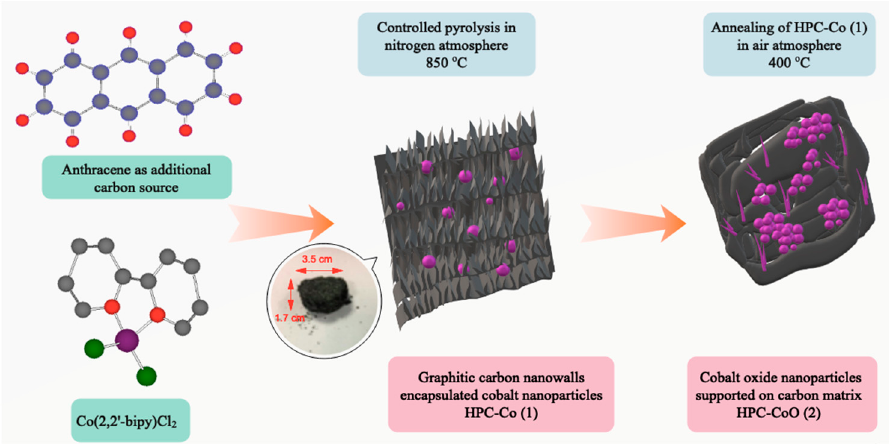
Figure 1. An illustrative diagram of synthesis of cobalt-carbon